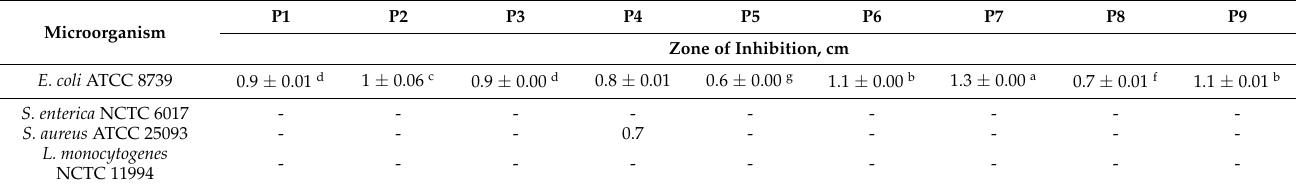
Table 4. Antibacterial activity of lupin protein